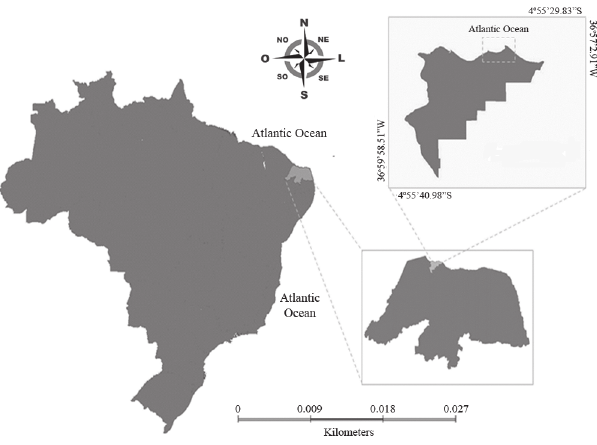
Fig. 1. Map of northwestern Brazil showing location of study area in São Cristóvão